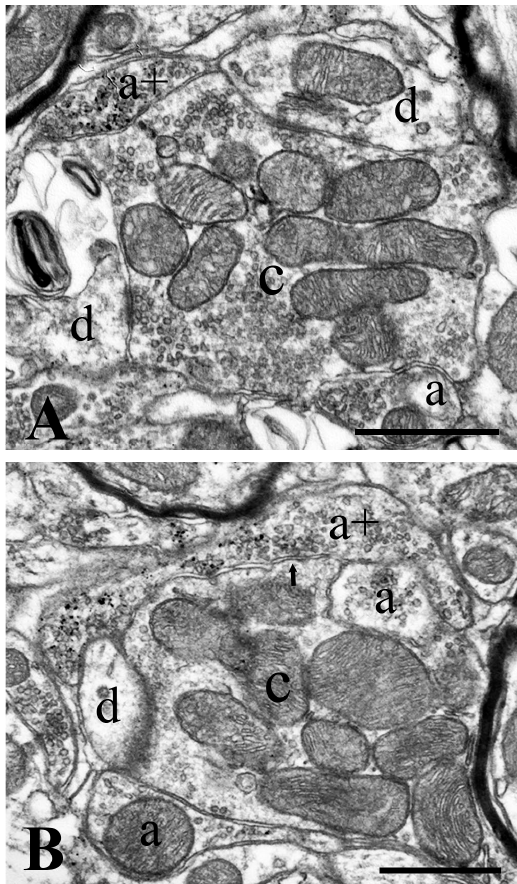
Figure 4. GlyT2 immunostained axon terminals in glomerular synaptic complexes. Electron micro- graphs showing glomerular synaptic complexes in laminae II–III of the superficial spinal dorsal horn at the L4–L5 levels of the spinal cord. Note that GlyT2 immunostained axon terminals make synaptic contacts with the central axons of the glomeruli. GlyT2 immunoreactivity appears as accu- mulated gold particles at perisynaptic locations and is distributed over synaptic vesicles ( A , B ). c: central axon terminal of the glomerular synaptic complex, a+: axon terminals immunostained for GlyT2, a: axon terminals negative for GlyT2, and d: dendrites postsynaptic to the central axon terminal. Arrows point to synaptic appositions. Bars: 0.5 µm.